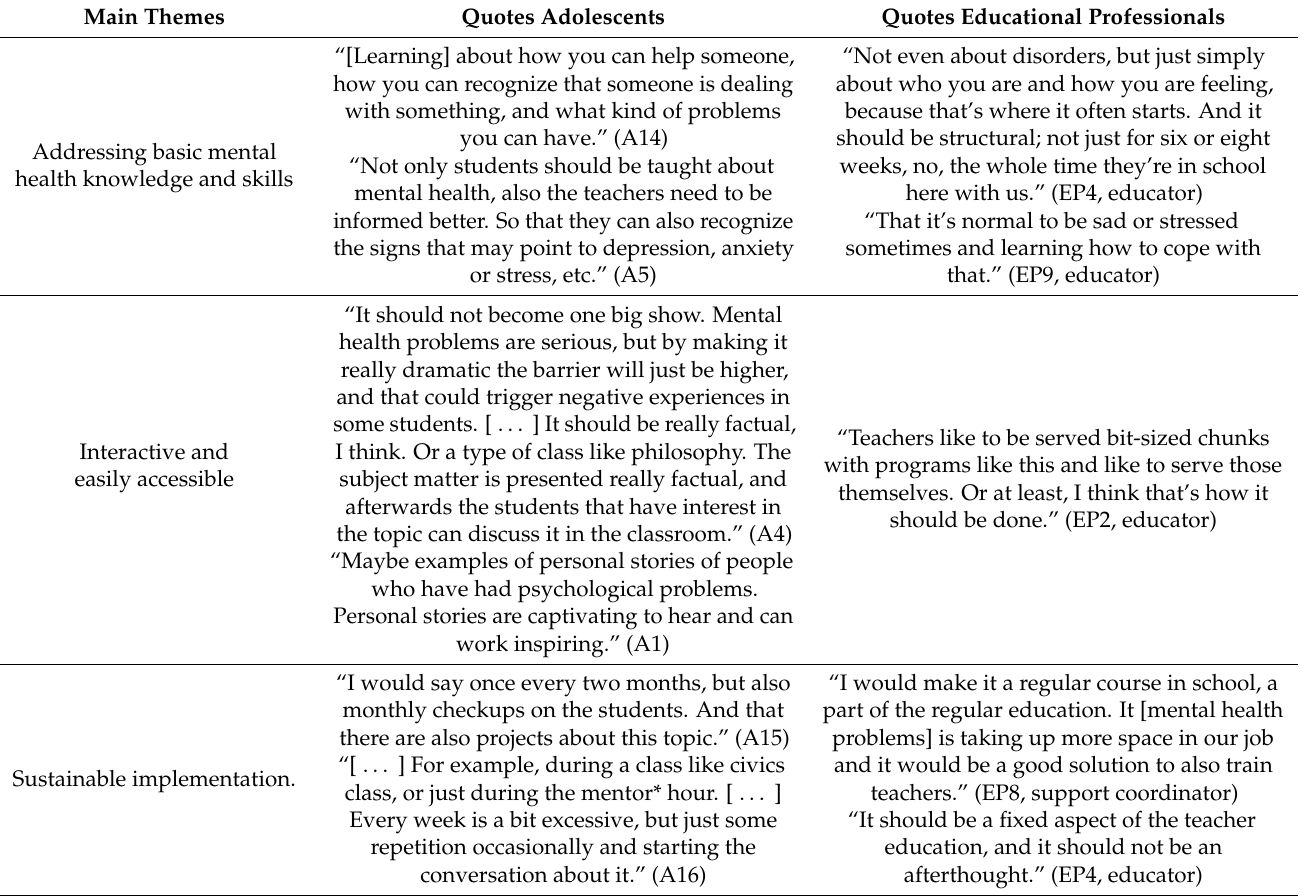
Table 2. Needs for MHL interventions in secondary